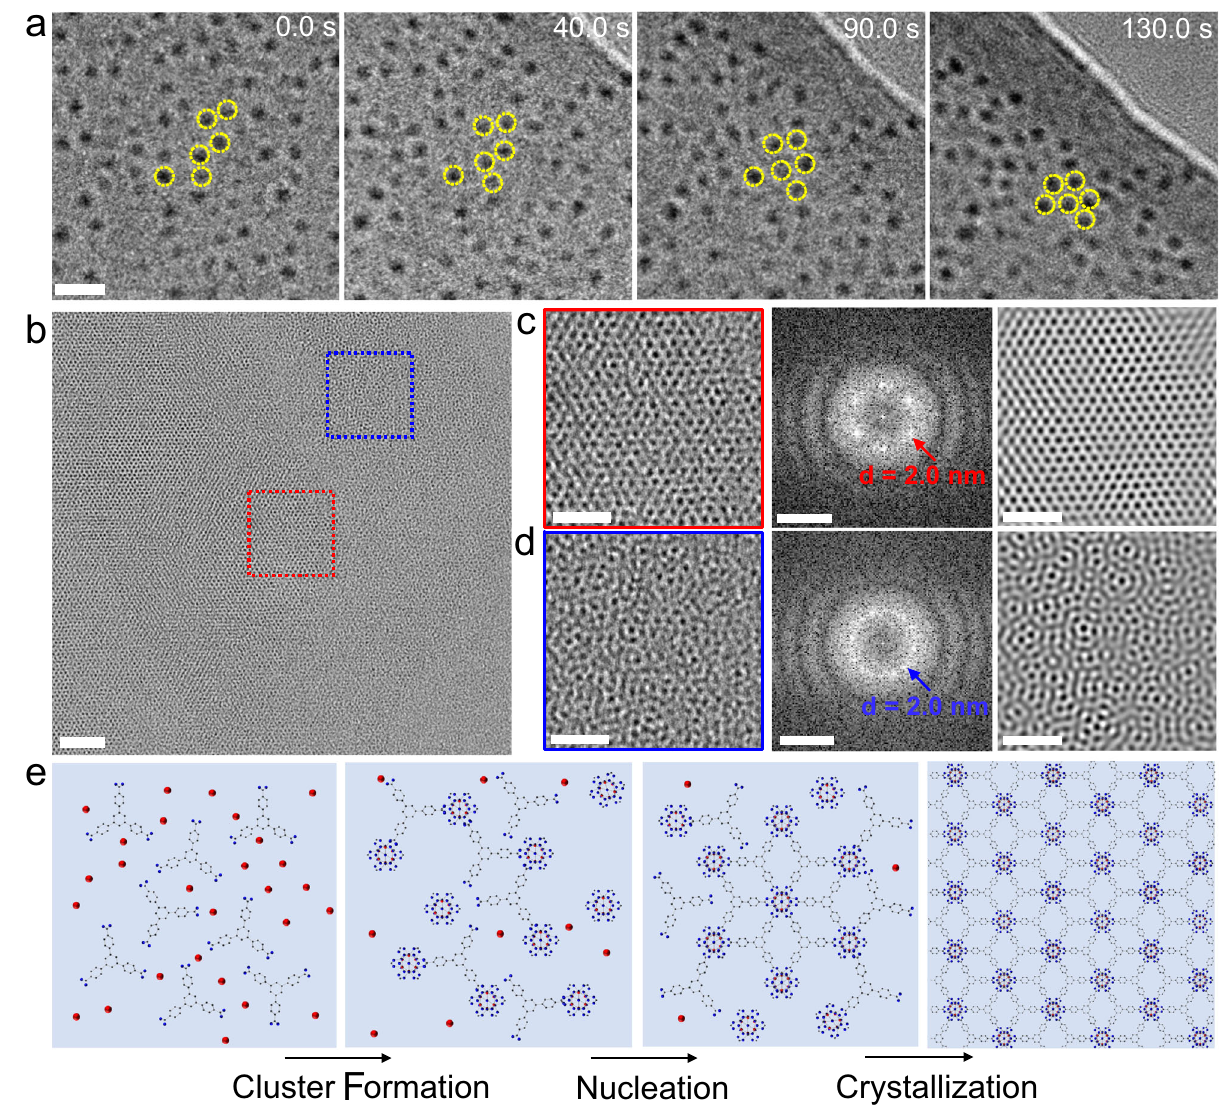
Fig. 2 | The formation process of Hf-MOLs. a Snapshots from Supplementary Movie 3 showing the Hf-clusters assembled into a hexagonal arrangement. b HRTEM image of Hf-MOLs after baking the growth solution at 120°C for 30min (early-stageproduct). c Enlargedimage(leftpanel)ofthered squareareashownin b , showing the bulk crystalline structure in more detail; the corresponding FFT (middle panel) and IFFT (right panel) images of the red region are also displayed. d Enlarged images (left panel) of the blue square region shown in b, showing the